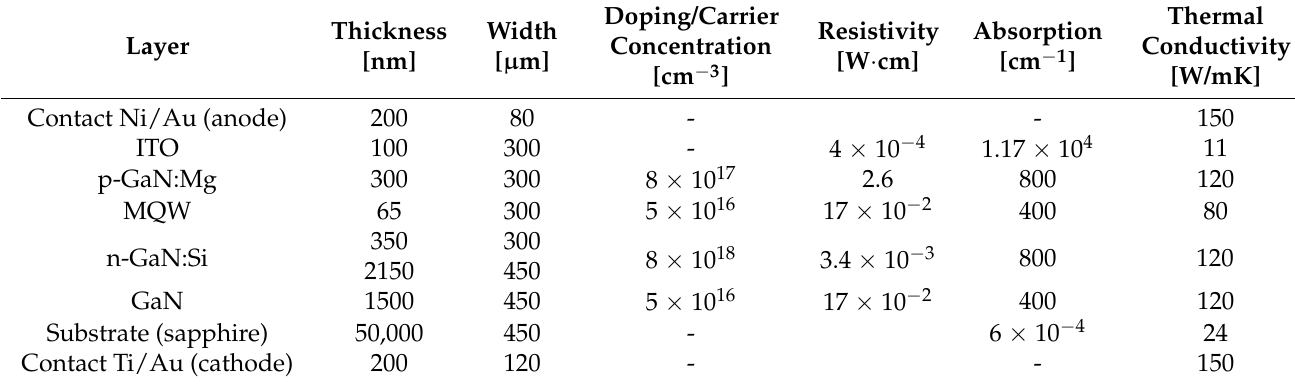
Table 1. Parameters and dimensions of the modelled preliminary planar GaN LED